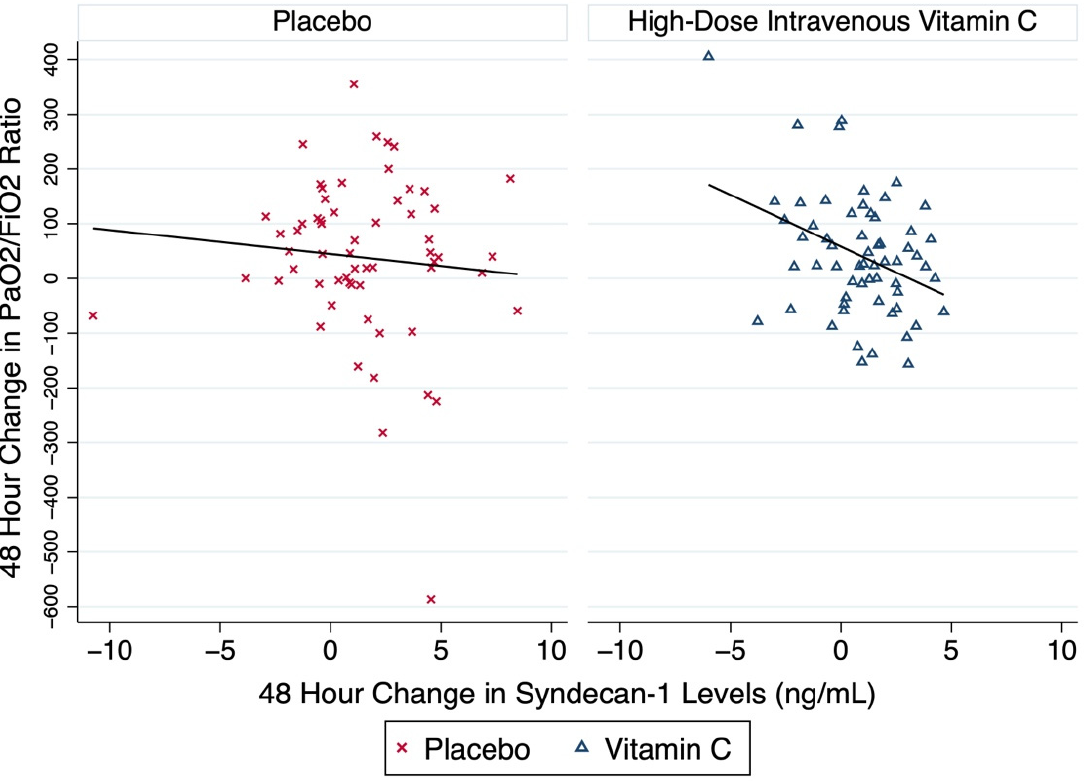
Figure 4. Scatterplots of the 48 h change in the PaO2/FiO2 ratio and the change in the plasma syndecan-1 during the same time-period. The figure illustrates the change of the PaO2/FiO2 ratio, a marker of oxygenation and lung injury which corresponds to the change in the plasma biomarker syndecan-1 among the two groups, Placebo and HDIVC. The linear fitted line corresponds to the regression line for each group: Placebo and HDIVC, respectively. The subjects of the placebo group are represented with red x symbols, and the subjects of the HDIVC group are represented with blue triangles. Abbreviations: FiO2, fraction of inspired oxygen; HDIVC, high-dose intravenous vitamin C; PaO2, arterial oxygen